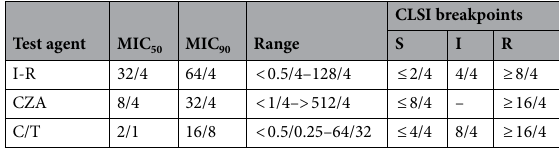
Table 1. MIC values for CFPA isolates (n = 20). All values are in